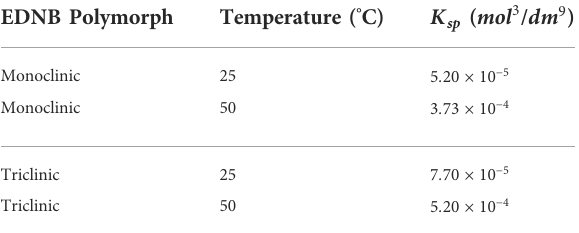
TABLE 2 Summary of literature data for the solubility products (Jones et al., 2005; Davey and Jones, 2008). EDNB Polymorph